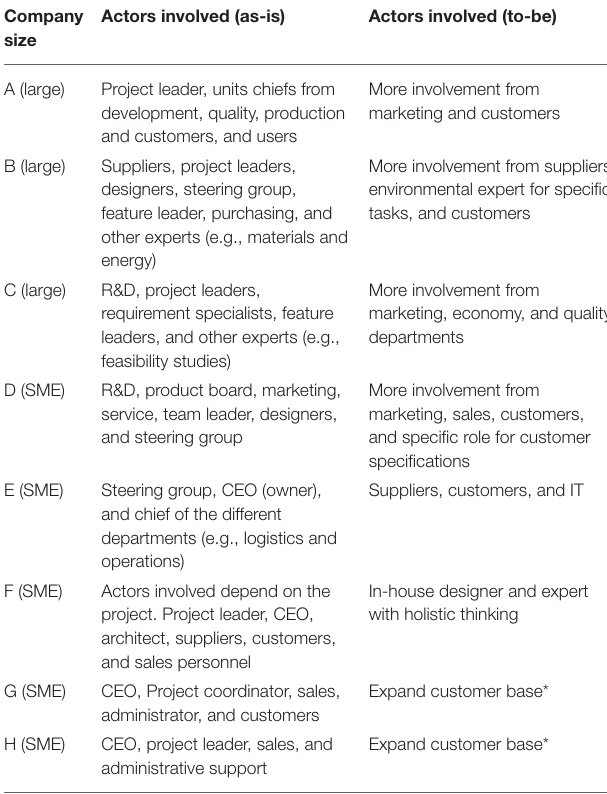
TABLE 3 | Actors involved in the early realization process (as-is and to-be). Company